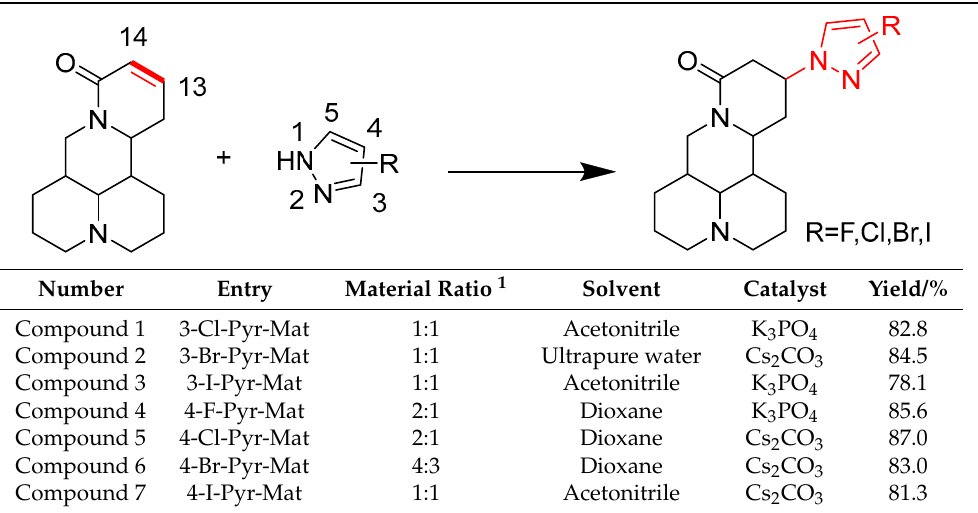
Table 1. The reaction conditions.